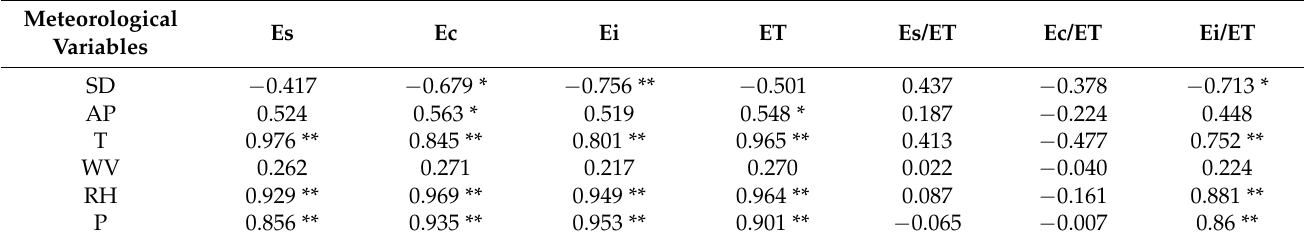
Table 2. Correlation coefficients between the seasonal variations in ET components and meteorological